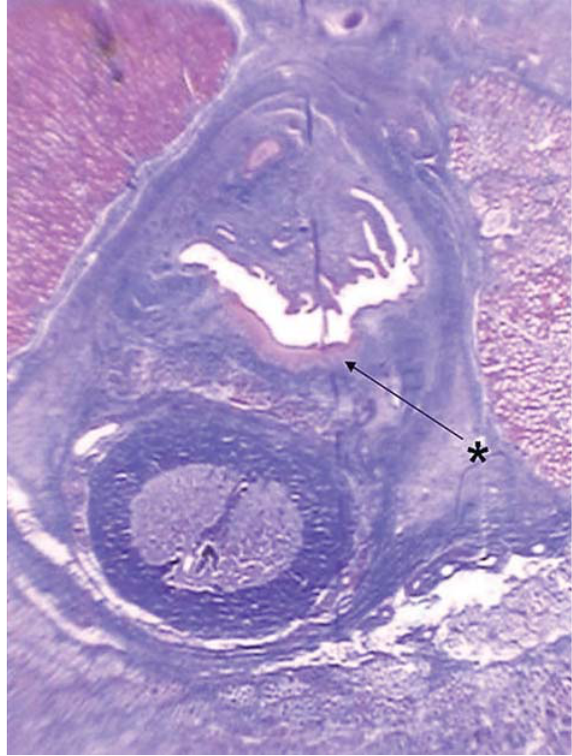
Figure 4 – The histological appearance of the graft at postopera- tive week